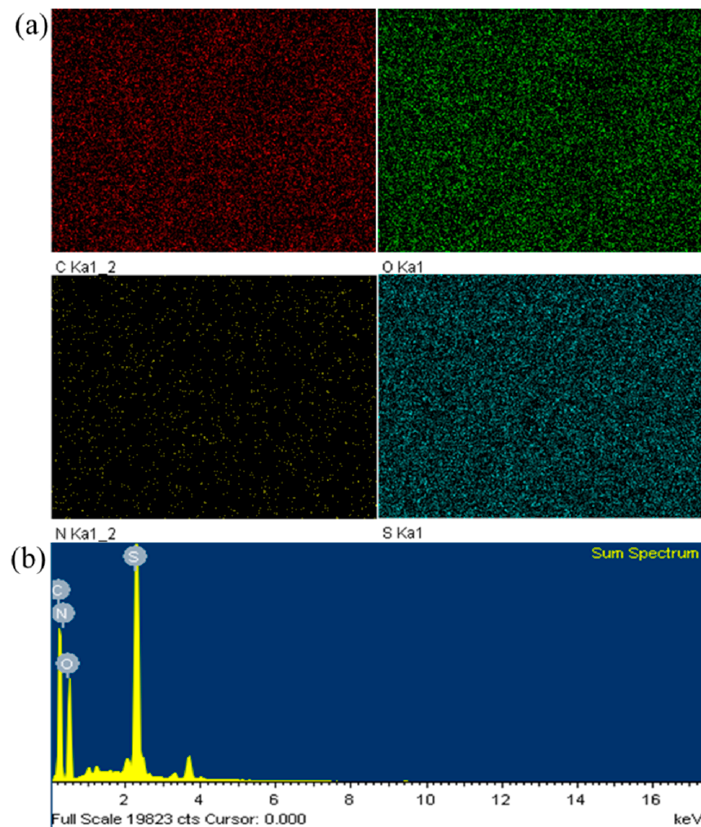
Figure 5. ( a ) Elemental mapping images for C, O, N, and S; and ( b ) EDS spectrum of SPEES-AM-02. SAXS measurements employed for the micro-phase separation of SPEES and SPEES-AMs. Since the location of the SAXS peak is related to the inter-cluster distance, the average dimension of the ionic clusters in the membranes, which constitute the ionic paths for proton migration in the PEMFCs, can be deduced from the SAXS data [7]. Figure 6 shows the SAXS patterns of the plain SPEES membrane and the SPEES-AM membranes. The average dimension of ionic clusters is calculated with the given Equation